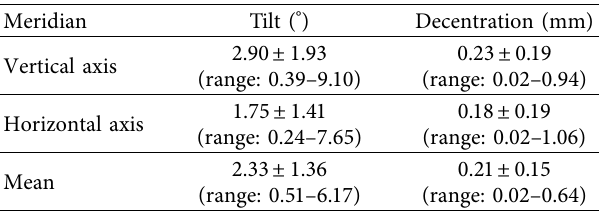
Table 3: IOL tilt angle and decentration